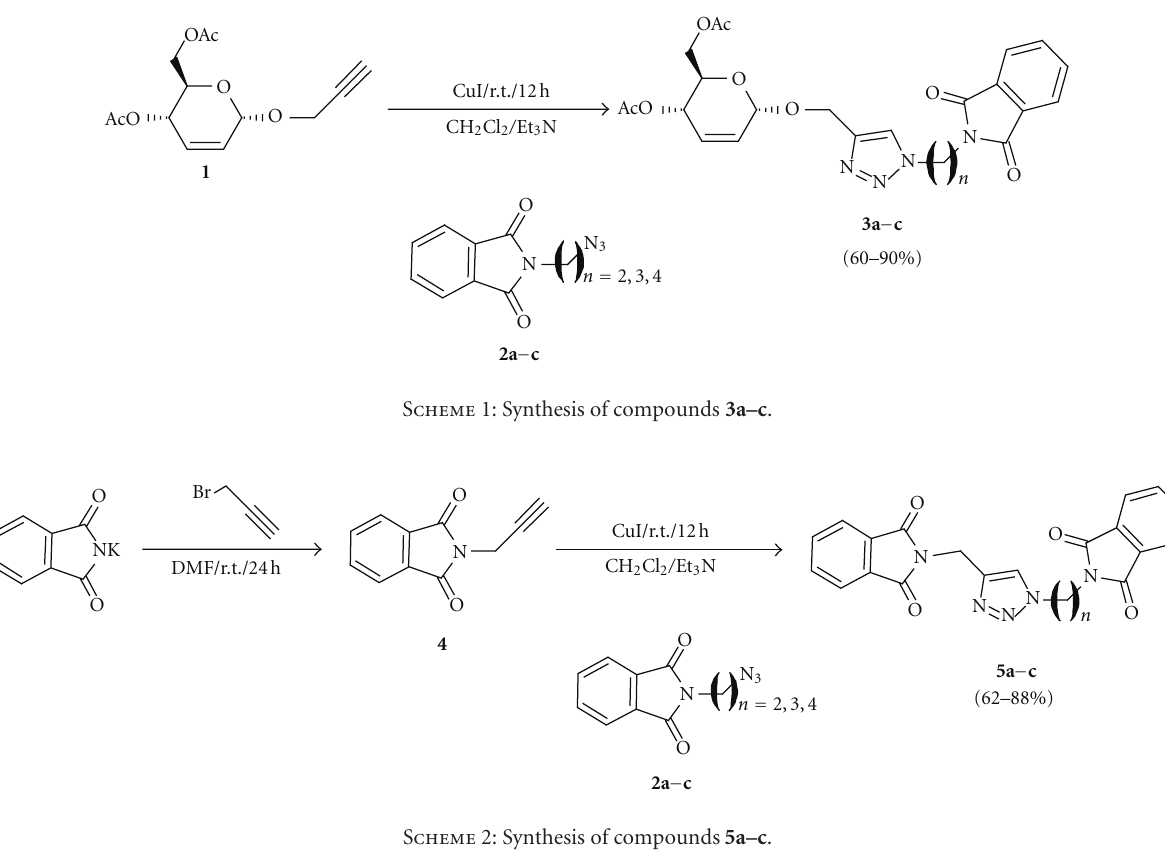
Scheme 2: Synthesis of compounds 5a–c .